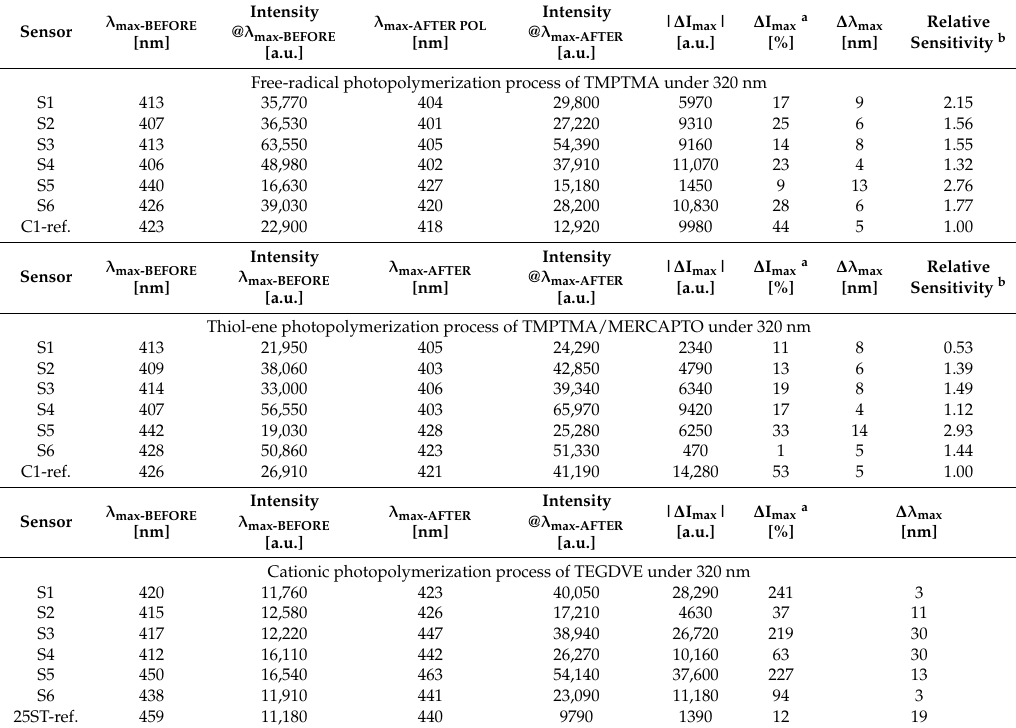
Table 3. Spectroscopic data of 2-amino-4,6-diphenyl-pyridine-3-carbonitrile derivatives during the photopolymerization